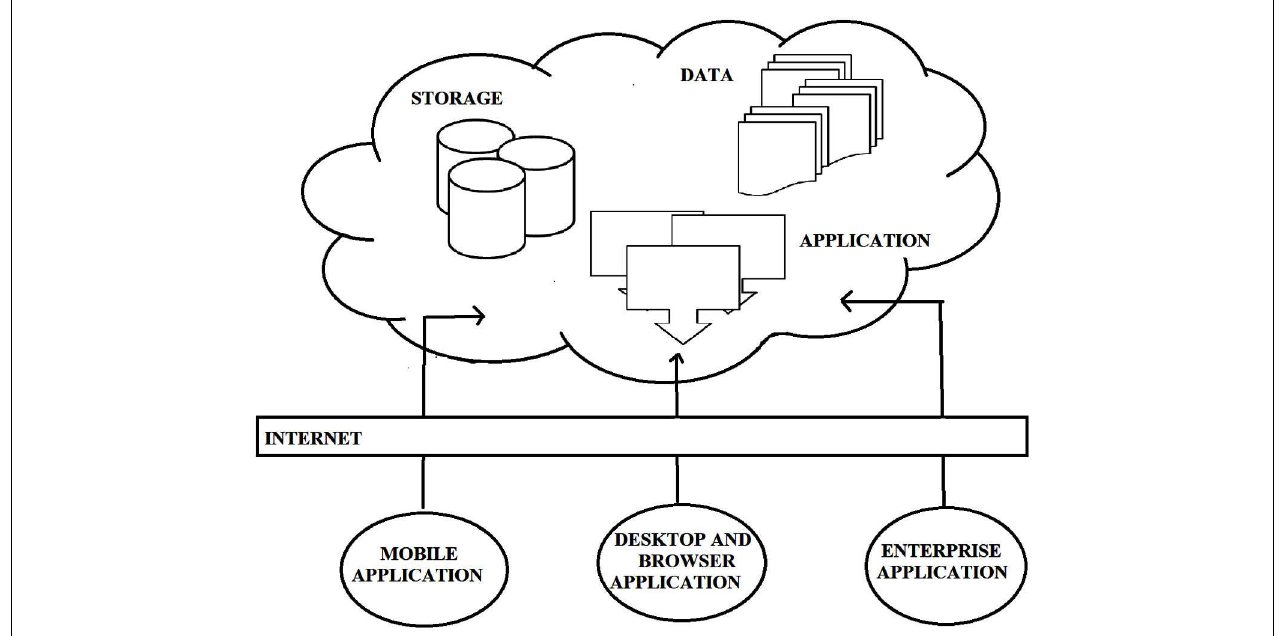
FIGURE 1 |The basic model of cloud computing along with components of cloud. Unlike traditional beliefs internet is just the medium to provide services rather cloud [courtesyTorry Harris Business Solutions (THBS), copyright 2009 (www.thbs.com) with kind permission and slightly